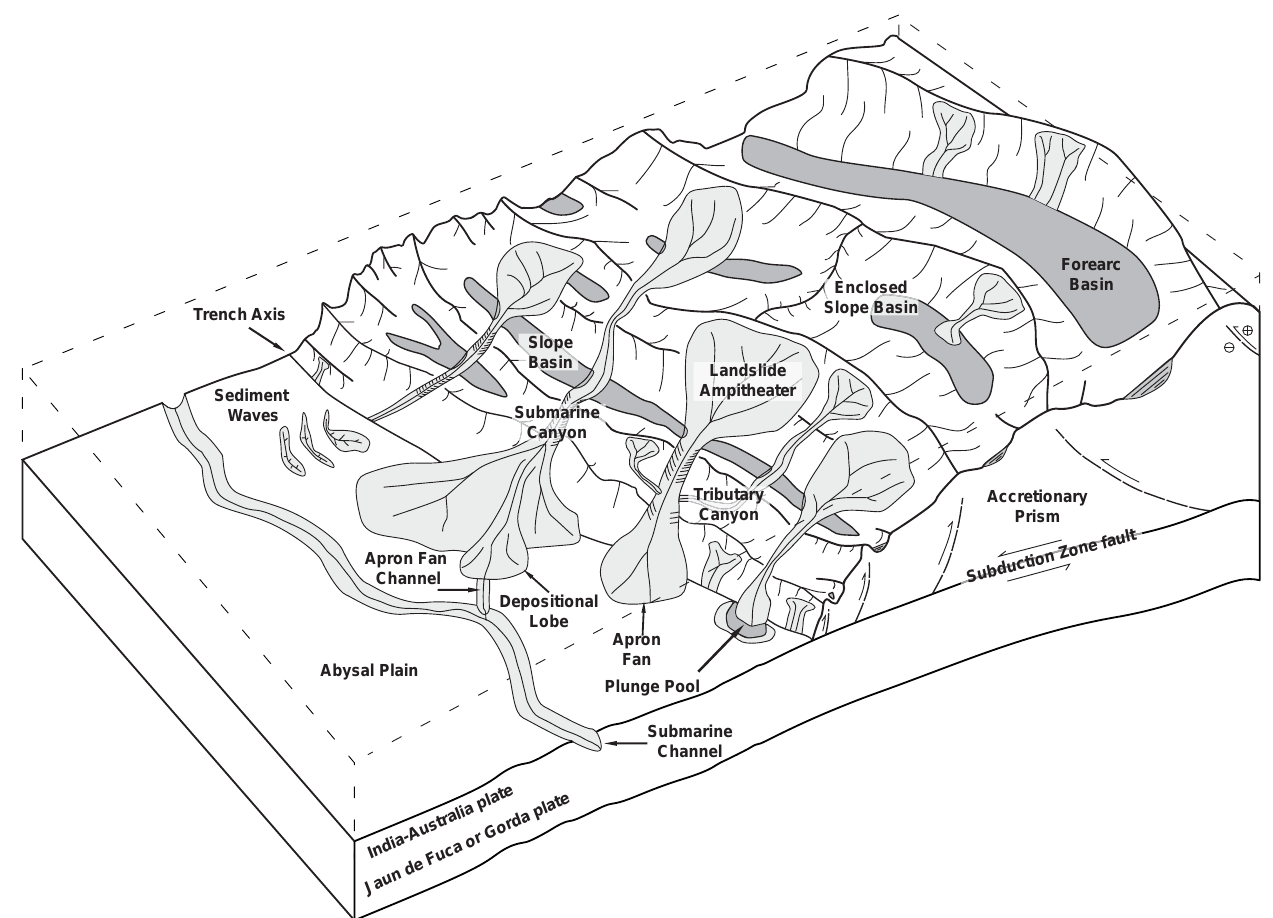
Fig. 1. Schematic illustration of geomorphic elements of subduction zone trench and slope sedimentary settings. Submarine channels, submarine canyons, dune fields and sediment waves, abyssal plain, trench axis, plunge pool, apron fans, and apron fan channels are labeled here and described in the text.